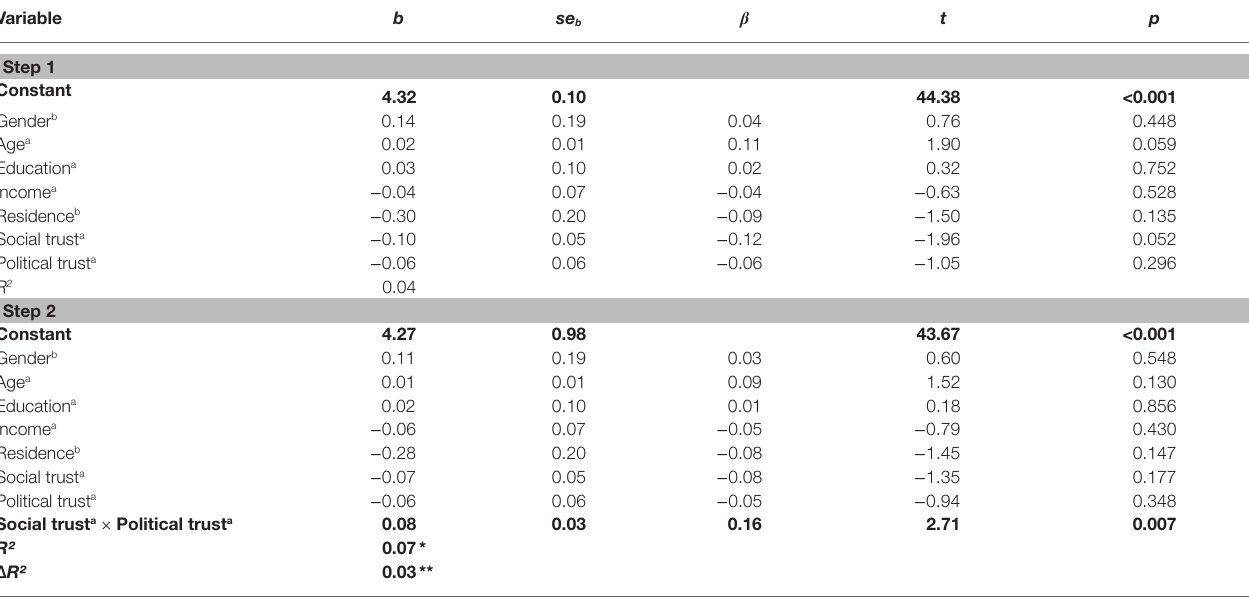
TABLE 2 | Hierarchical regression results on the dependent variable social distancing for Study 1. Variable